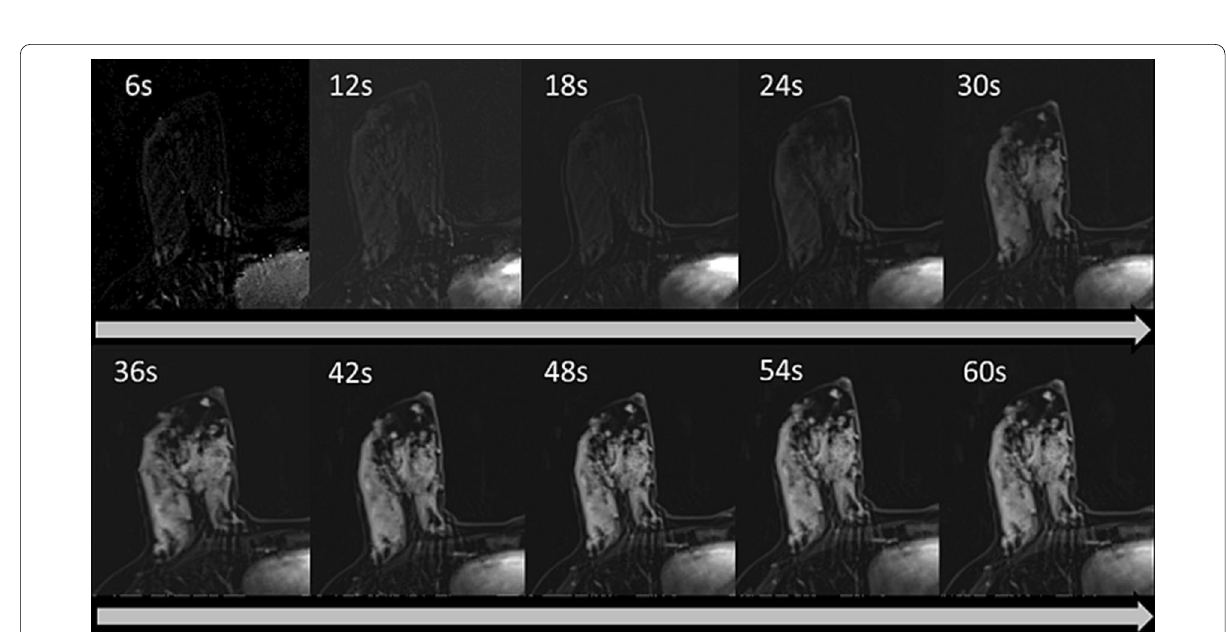
Fig. 21 Ultrafast DCE‑MRI of the lactating breast. Subtracted ultrafast DCE‑MRI of the right breast of a healthy lactating patient (34 years old, lactation duration 18 months) are presented. Using grasp‑vibe, a compressed‑sensing technique, acquisition of ten consecutive T1‑weighted images in the first minute post injection was enabled. Note : the prominent lactation‑induced BPE (grade 3) appears only in the fifth acquired T1 image, approximately after 30 s, and further enhances in the following